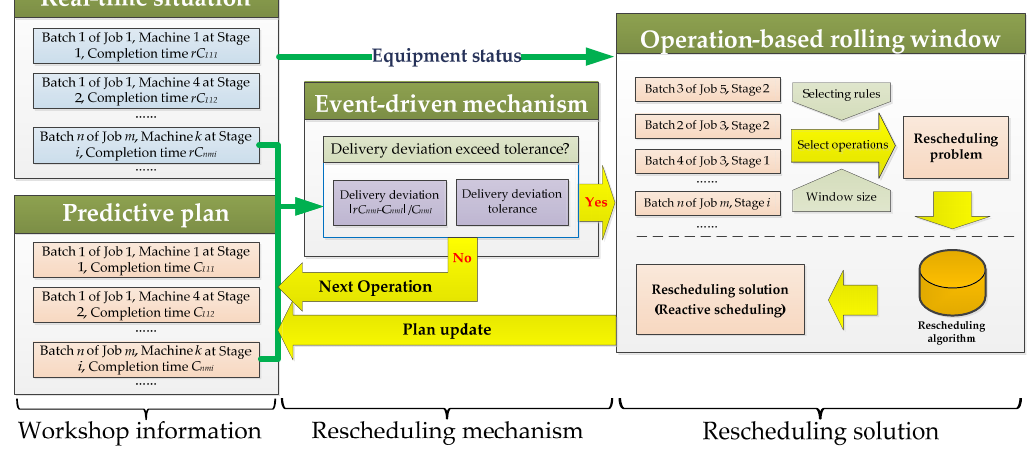
Figure 3. Event ‐ driven rescheduling strategy. Figure 3. Event-driven rescheduling